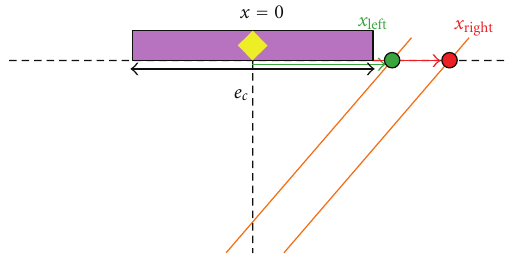
Figure 15: Ratio calculation by taking into account shadows. Case E configuration (reflected area at the right side of the PV panel).